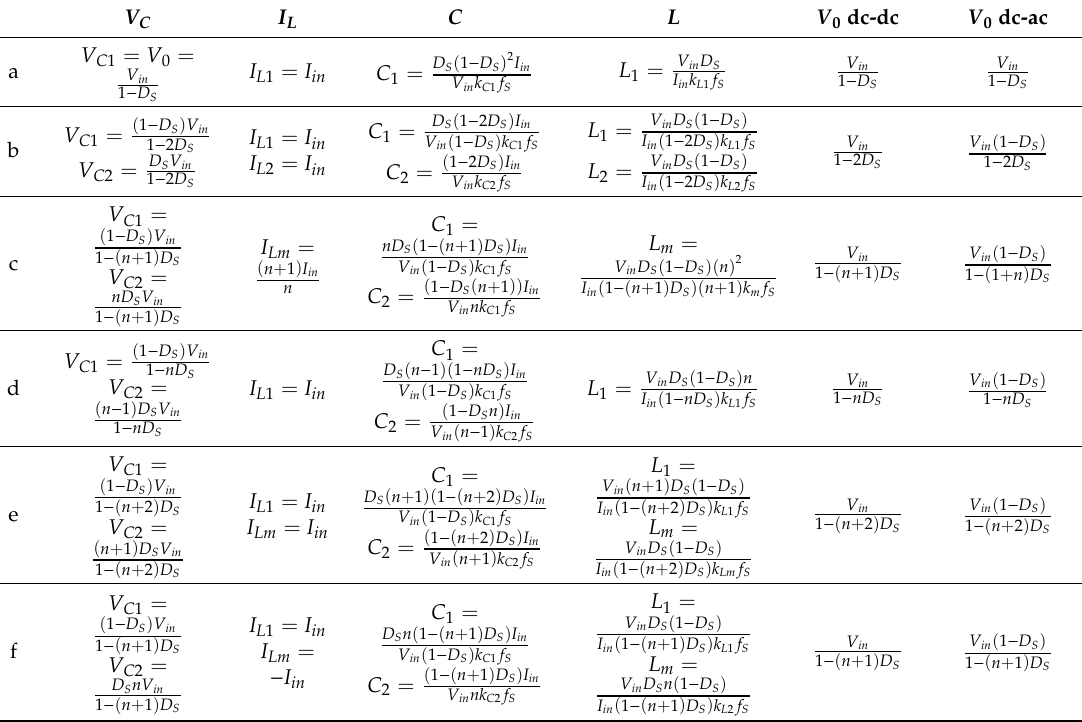
Table 1. Summarized equations for selected topologies 1